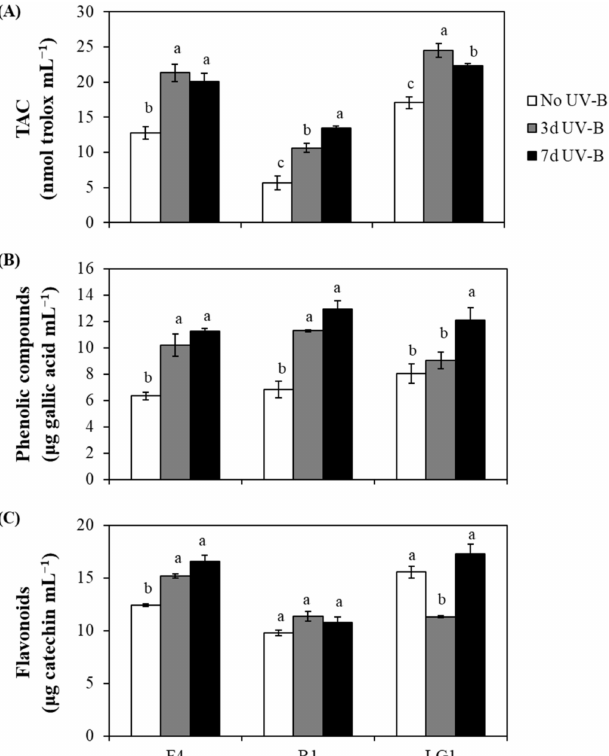
Figure 2. Effect of UV-B the non-enzymatic antioxidants in microalgae subjected to cigarette butt (CB)-derived wastewater treatment. ( A ) Total antioxidant capacity (TAC), ( B ) phenolic compounds and ( C ) flavonoids were determined in each microalgal strain (F4, R1 and LG1) in 7-day cultures. Microalgae were exposed to wastewater and sequential (3 d UV-B) or parallel (7 d UV-B) UV-B treatments. The UV-B exposure level was set at 1.7 W m − 2 and supplemented with 70 µ mol m − 1 s − 1 photosynthetically active radiation (PAR) for 20 min each day. The control microalgal group only received PAR (No UV-B). For more details, see Section 4. Different letters represent significant differences ( p < 0.05) between UV-B treatments within the same strain. Data are expressed as means of 4 different replicates ± standard error